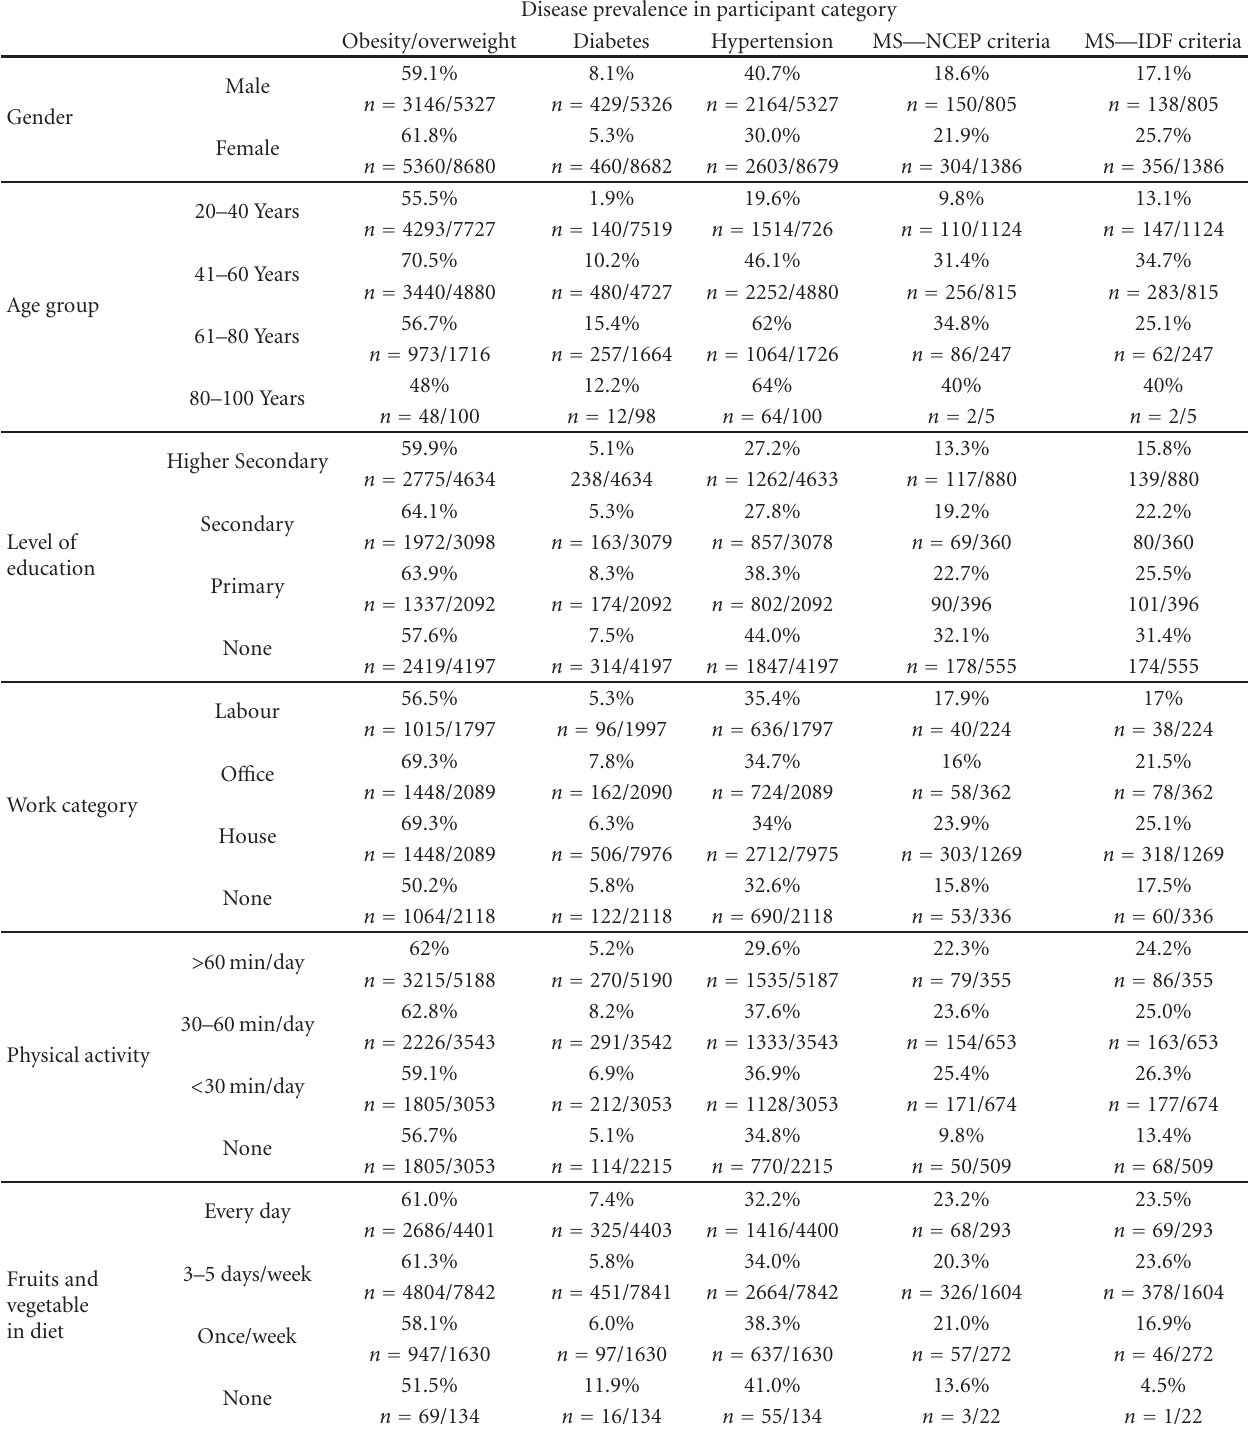
Table 4: Demographic details and prevalence of metabolic syndrome and other